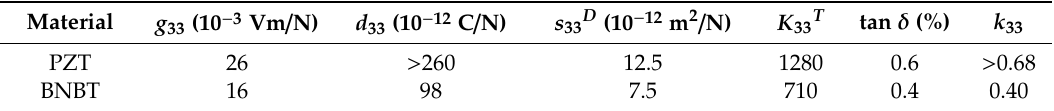
Table 2. Piezoelectric ( g 33 and d 33 ) and elastic ( s 33 D ; or Y 33 = 1 / s 33 ) coe ffi cients, dielectric permittivity and losses ( K 33 T and tan δ ), and electromechanical coupling factors ( k 33 ) of the lead-containing, hard lead titanate zirconate (Navy I-type PZT; APC International, Ltd., Mackeyville, PA, USA) and lead-free, tetragonal bismuth sodium barium titanate (BNBT) (PIC700; PI Ceramic GmbH, Lederhose, Germany) commercial ceramic materials (longitudinally poled cylinders of 6 mm diameter and 15 mm length). The catalog values are shown for PZT, and PIC700 was characterized using the resonance method ( f s = 148.3 kHz, f p = 160.1 kHz).